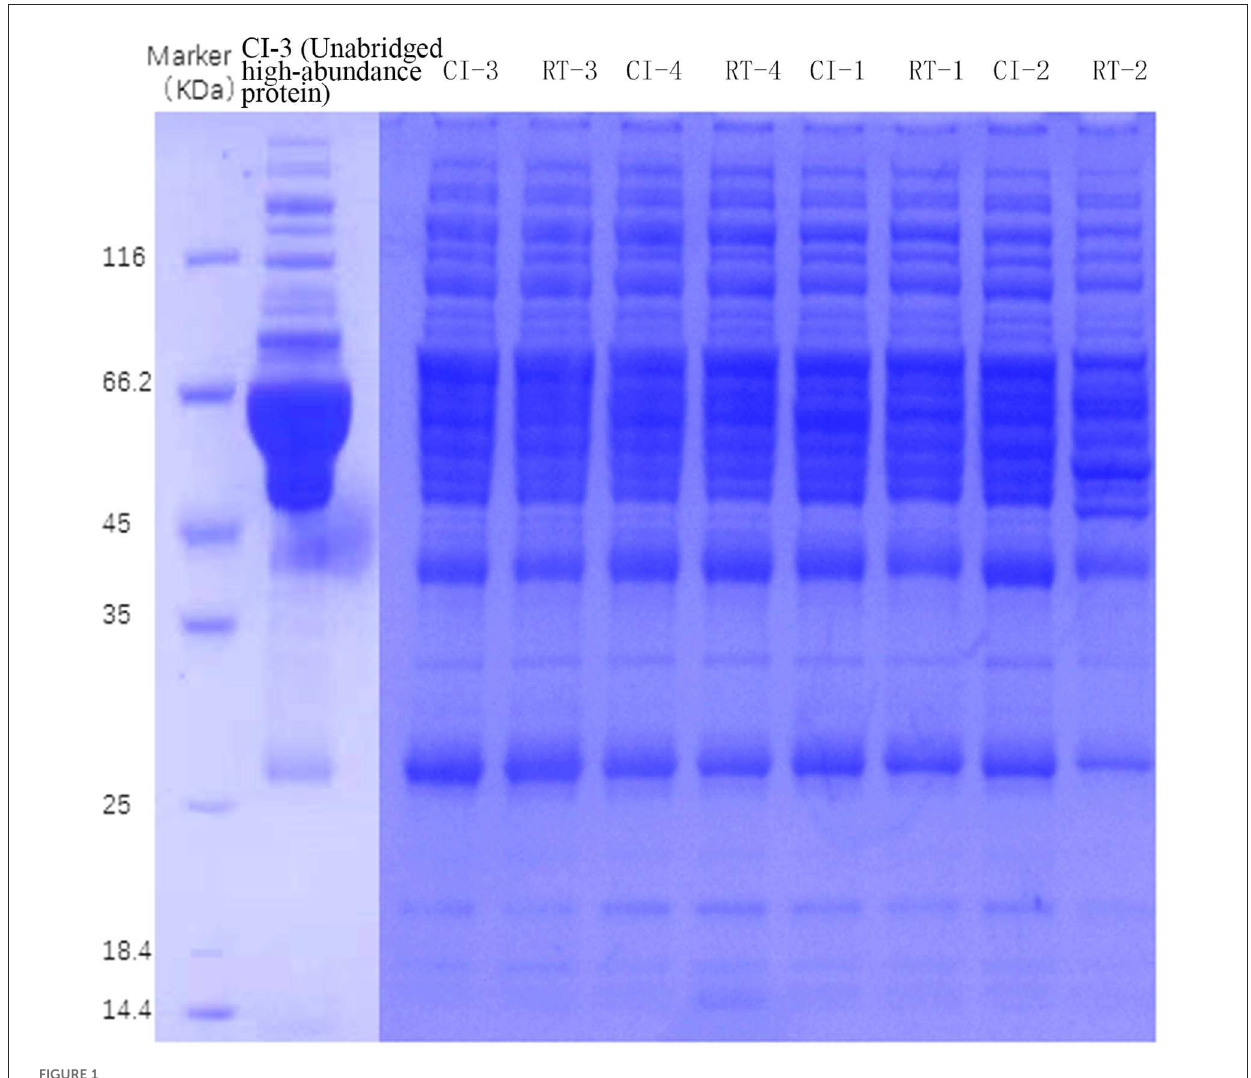
FIGURE1 SDS-PAGE electropherogram of